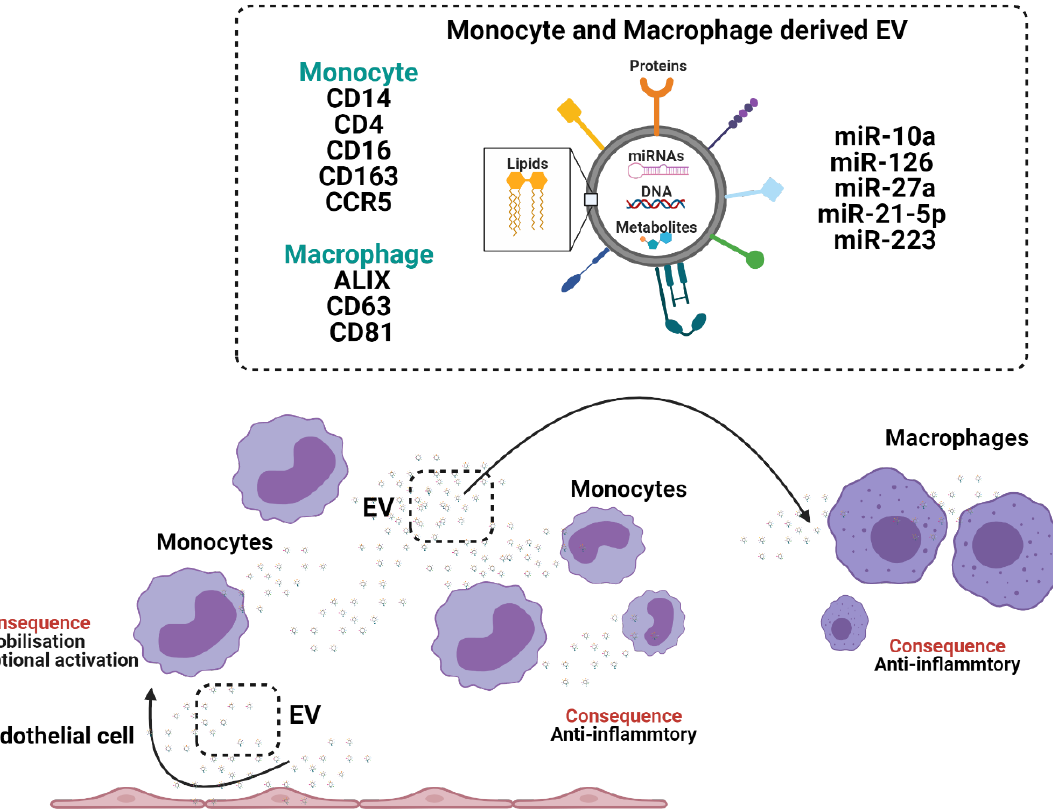
Figure 2. The crosstalk between neutrophils, monocytes and macrophages through the generation and release of extracellular vesicles (EV). Neutrophil derived microvesicles (NVDMs). Myeloperoxidase (MPO).